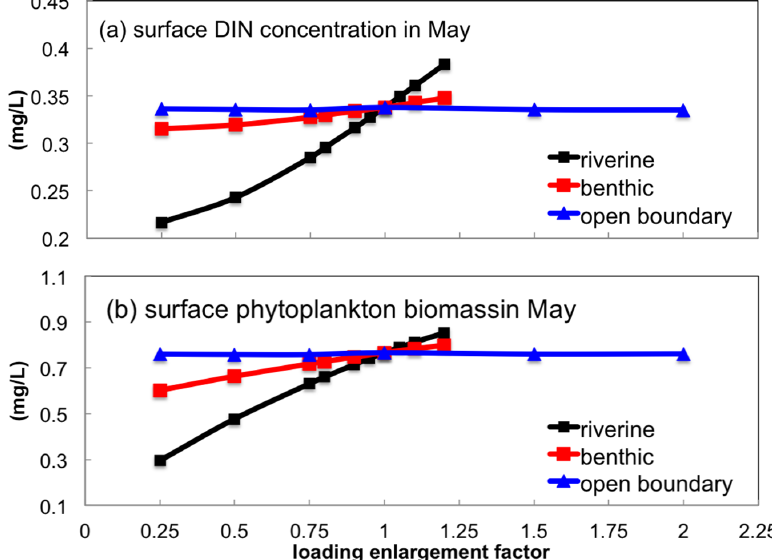
Figure 12. The relationship between the enlargement factor of riverine, benthic and open boundary nutrient loading (see Table 2) and the ( a ) surface dissolved inorganic nitrogen concentration and ( b ) phytoplankton biomass in May